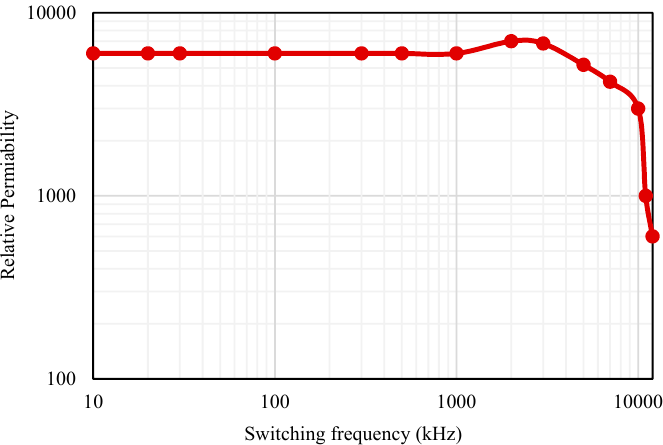
( b ) Figure 15. Simulation results for the hybrid ANPC inverter for the output voltage (V an ), current (I an ) and common-mode voltage (CMV) with ( a ) unity power factor, ( b ) non-unity power factor. 4. Conclusions To sum up, this paper presents a three-level hybrid ANPC topology that includes Ga 2 O 3 -based MOSFET as well as Si-based IGBTs. This inverter has split inductors at the